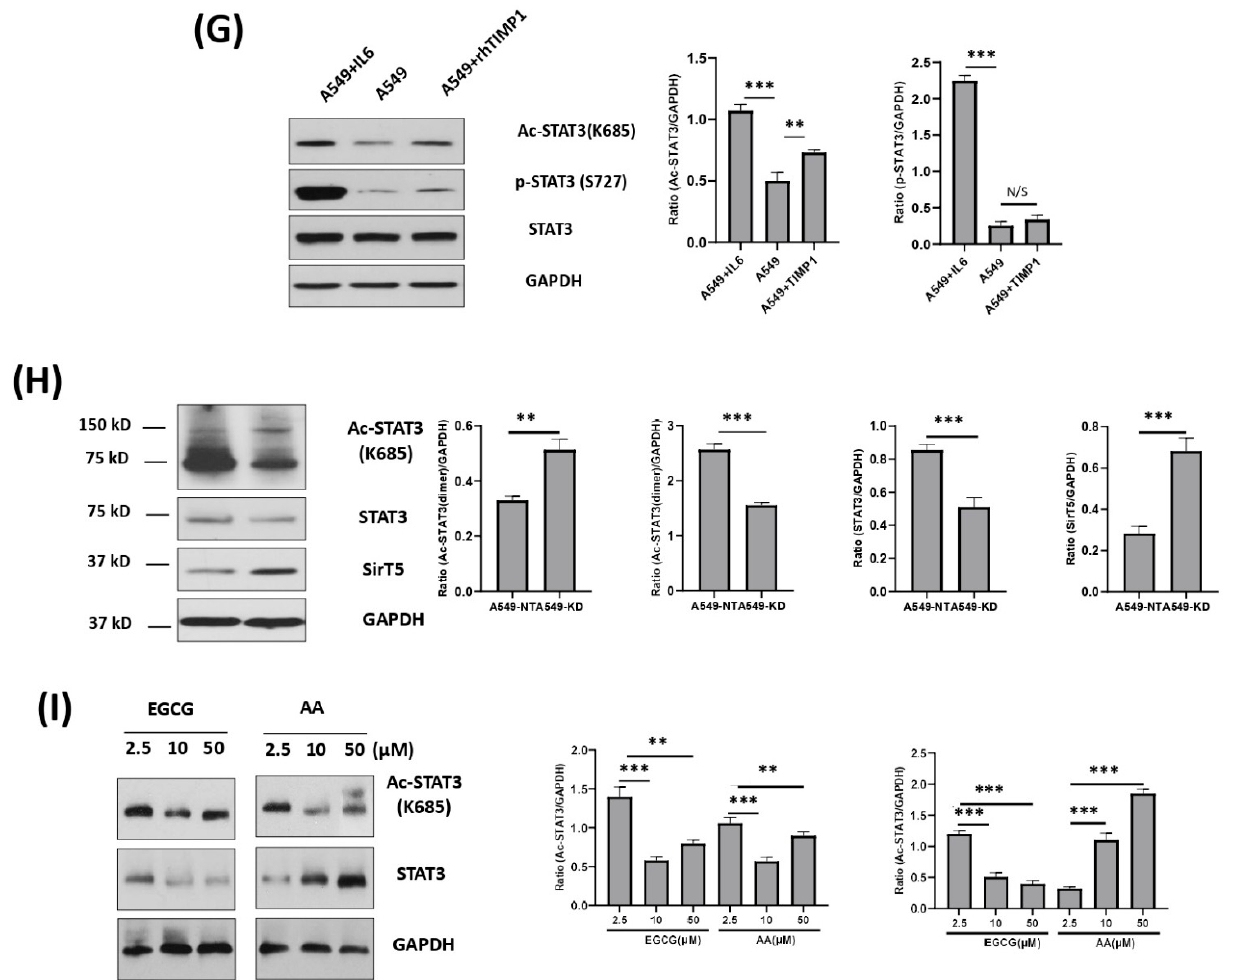
Figure 3. TIMP-1 affects STAT3 activation via its acetylation in NSCLCs. NSCLC cells (A549 and H460) derived TIMP-1 non-target (NT) control and knockdown (KD) clones were cultured in complete medium with or without 10% FBS for indicated hours. ( A , B ) Acetyl-STAT3, total STAT3 and GAPDH protein expression levels were detected with whole cellular lysates by Western blot. Data were quantified by densitometry using ImageJ and normalized to reference genes as loading control. ( C ) The nuclear and cytoplasmic protein was extracted and then detected for Acetyl-STAT3, total STAT3, β -actin and β -tubulin by Western blot. ( D ). Phosphor-STAT3, total STAT3 and histone H3 were detected with whole cellular lysates of NSCLC cells (A549 and H460)-derived TIMP-1 NT control and KD clones by Western blot. ( E ) The mitochondrial plasma and mitochondrial membrane protein were extracted with isolated mitochondria from NSCLC cells (A549 and H460)-derived TIMP-1 NT control and KD clones. Acetyl-STAT3, total STAT3, β -tubulin, porin, and histone H3 were detected by Western blot. ( F ) Representatives of mass spectrum of four specific peptides of STAT3. ( G ) NSCLC cells (A549) were treated with recombinant human IL-6 (100 ng/ μ L) and TIMP-1 (100 ng/ μ L) for 24 h. Whole-cell lysates were used to detect Acetyl-STAT3, phosphor-STAT3, and total STAT3 by Western blot. ( H ) Acetyl-STAT3, total STAT3 and Sirt5 were detected with NSCLC cells (A549) derived TIMP-1 NT control and KD clones by Western blot. ( I ) NSCLC cells (A549) were treated with EGCG and AA at indicated concentrations for 24 h. Cell pellets were detected for Acetyl-STAT3 and total STAT3. GAPDH was used as loading control. Data are representative of three independent experiments. Statistical significance is indicated by: N/S not significant, * p < 0.05; ** p < 0.01; and *** p < 0.001. Our data indicated that the levels of the monomer form of acetyl-STAT3 decreased with TIMP-1 KD, whereas there was an increase in the level of acetyl-STAT3 dimers.